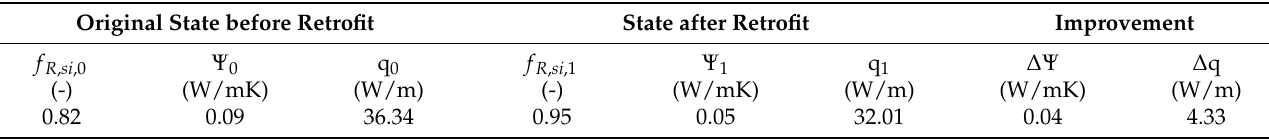
Table A29. Quantifiable results of the thermal bridge retrofit of a connection of a rooftop on a wall (ThermCad thermal bridge simulation